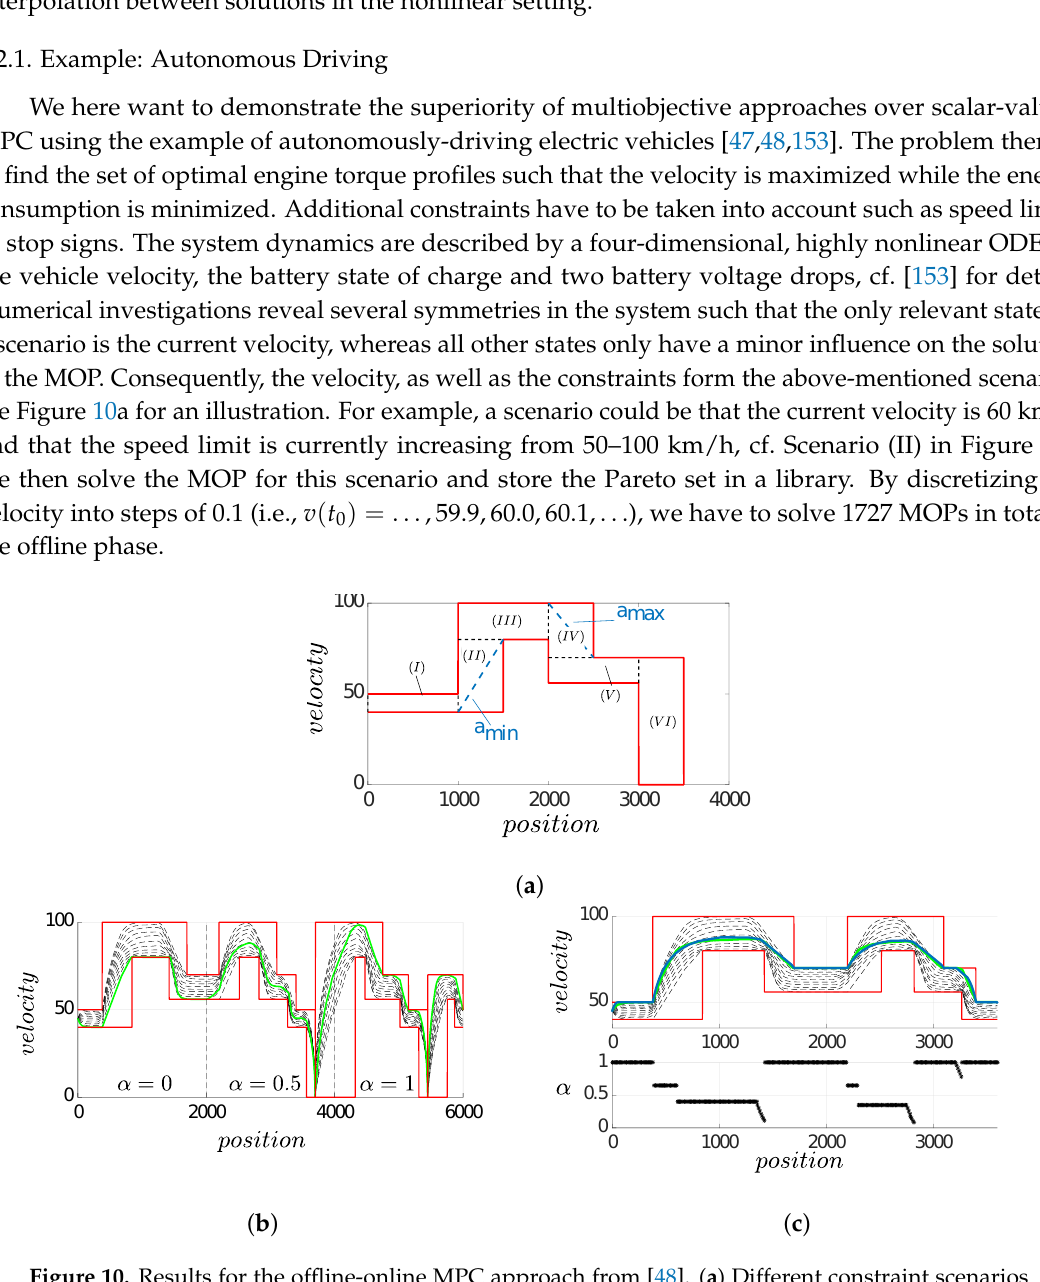
Figure 10. Results for the offline-online MPC approach from [48]. ( a ) Different constraint scenarios ((I)–(VI)), i.e., constant velocity, acceleration, deceleration and stopping. ( b ) Example track driven with the MPC algorithm. The red lines define the velocity bounds; the black dashed lines are trajectories corresponding to a constant weight α ; and the green line is a trajectory where the weight is changed from 0 (energy efficient) over 0.5 (average) to 1 (fast). ( c ) Comparison between the MPC algorithm (coupled with a simple heuristic for the weighting) and the global optimum obtained via dynamic